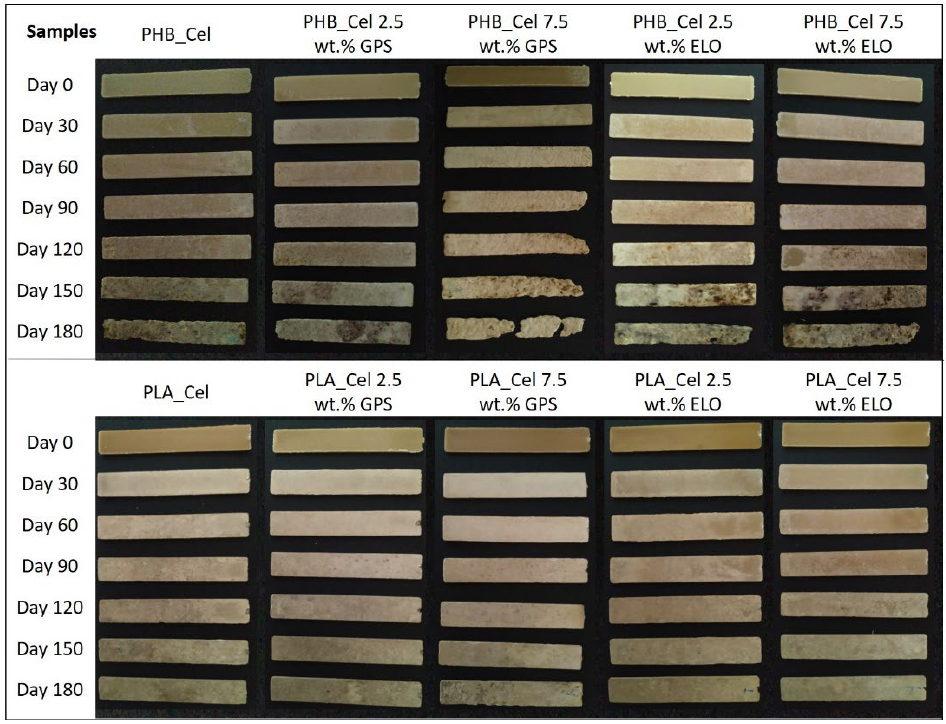
Figure 9. Digital photographs of the test specimens prior and after burial tests in compost medium for 30, 60, 90, 12 and 180 days.